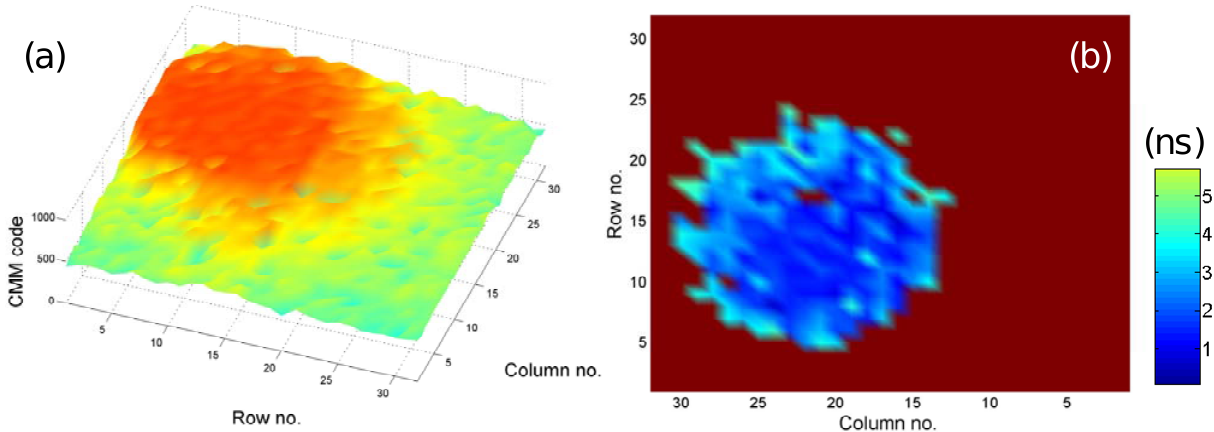
Figure 4. ( a ) (Video) Movie of CMM lifetime codes of fluorescent beads in a micro-channel at a video frame rate of 50 fps and ( b ) a single frame of the estimated lifetime